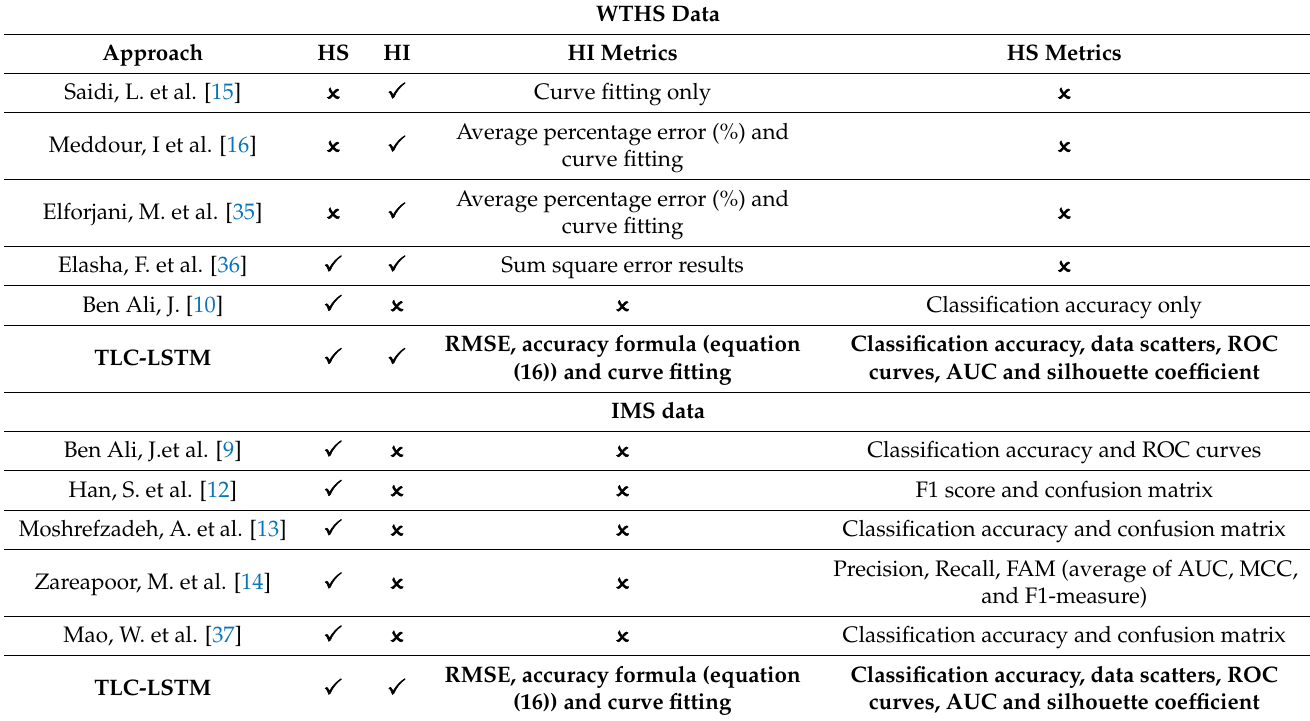
Figure 14. HI classifiers ofarea under the probability curve beneath the receiver operating charac- teristic (AUC-ROC) curves.